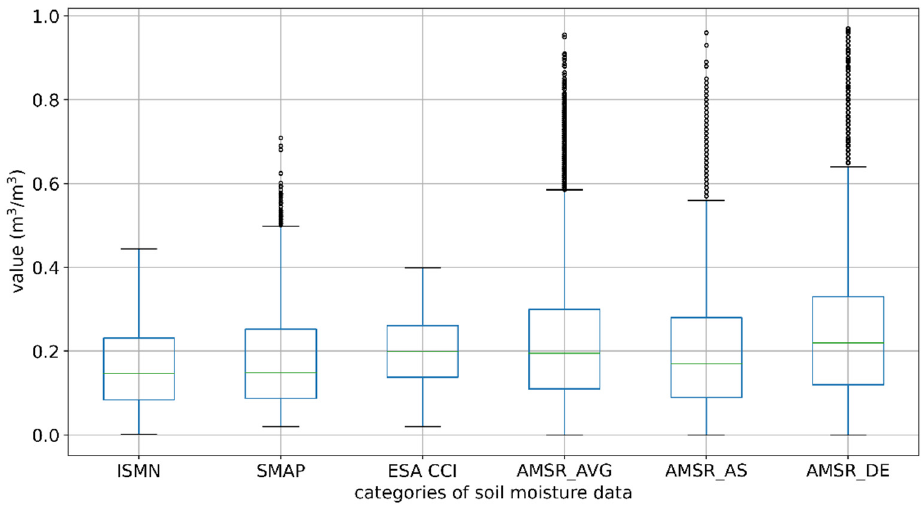
Figure 8. Boxplot of ISMN data and five products.